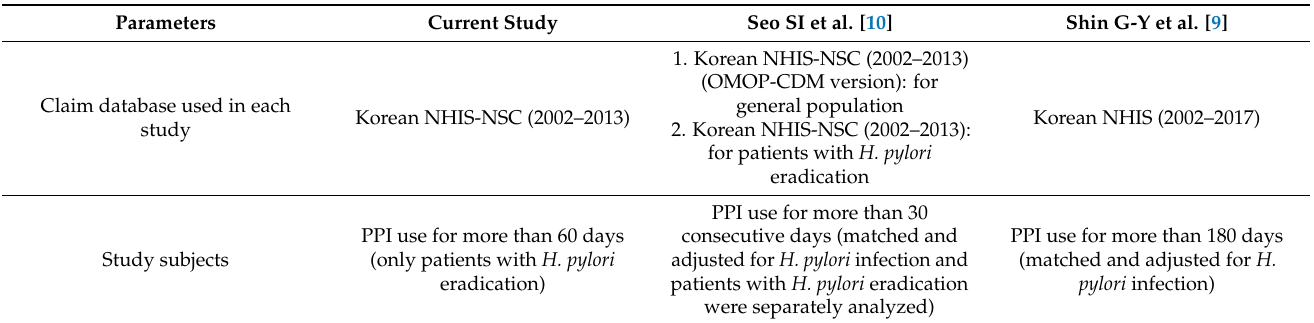
Table 1. Comparison of operational definitions and characteristics of previous population-based cohort studies with those of the current